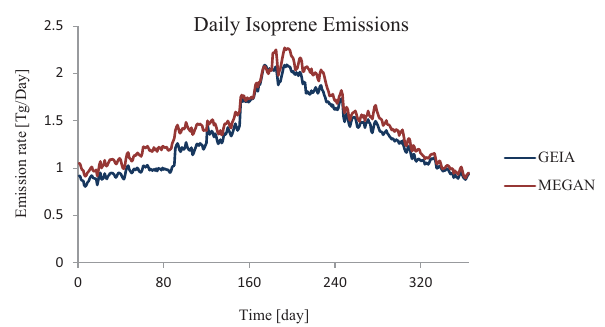
Fig. 2. Daily total isoprene emissions calculated by both GEIA and MEGAN in the study area for